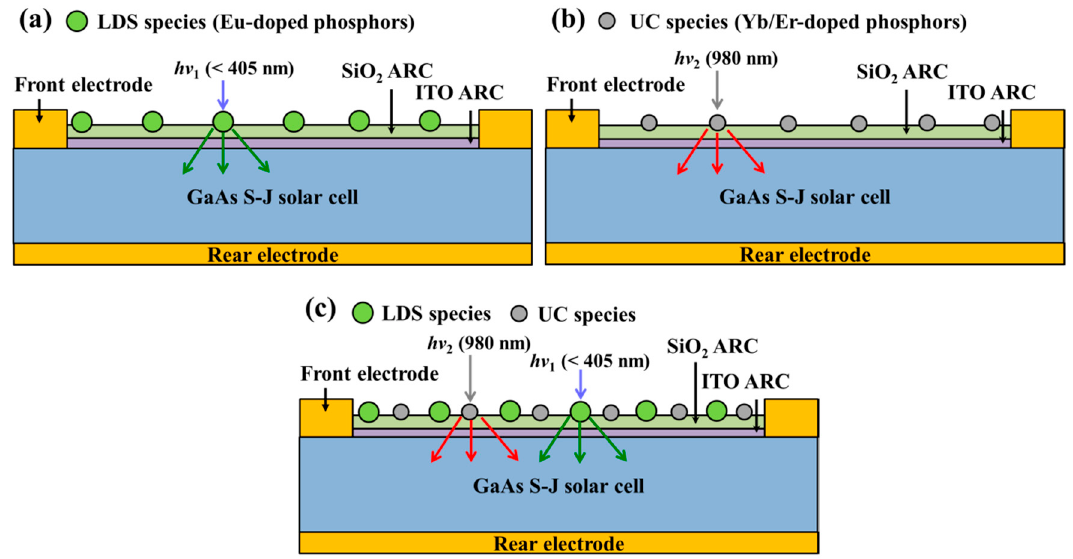
Figure 3. Schematic diagrams of GaAs single-junction solar cells coated with ( a ) Eu-doped phosphors in SiO 2 , ( b ) Yb/Er-doped phosphors in SiO 2 , and ( c ) a combination of Eu-doped and Yb/Er-doped phosphors in SiO 2 .